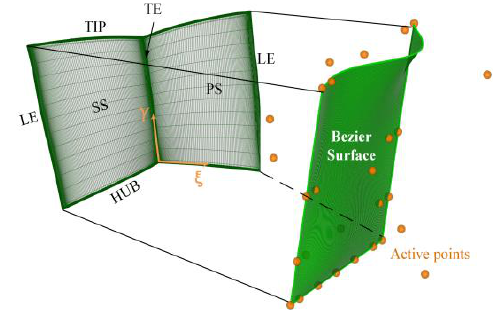
Figure 6. Bezier surface modeling of a compressor blade.